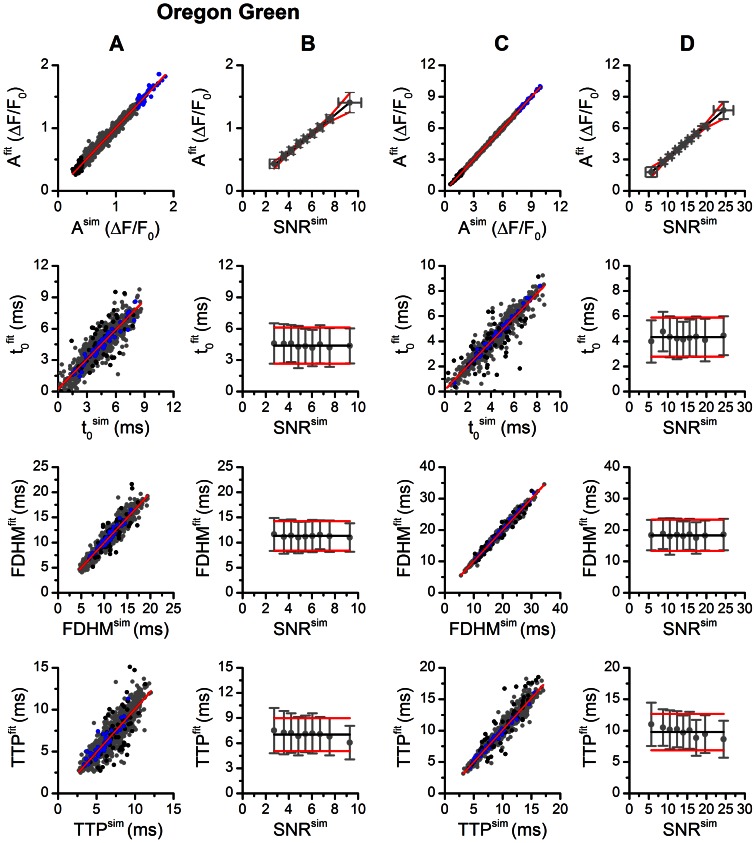
Determination of the accuracy and the precision of the estimated parameters of OG-5N (A, B) and Fluo-3 spikes (C, D).
A, C – correlation between the simulated and the fitted parameters (grey circles). Red line is the linear fit. Parameters of the spikes with the bottom 5% of SNR values (2.38±0.04 for OG-5N and 4.33±0.15 for Fluo-3) and of spikes with the top 5% of SNR values (10.11±0.12 for OG-5N and 26.68±0.29 for Fluo-3) are shown as black and blue circles, respectively. Pearson correlation coefficients between the parameters of simulated OG-5N calcium spikes and parameters of their fits were 0.986, 0.893, 0.869 and 0.942 for the A, t0, TTP and FDHM values, respectively. Pearson correlation coefficients between the parameters of simulated Fluo-3 calcium spikes and parameters of their fits were 0.999, 0.939, 0.962 and 0.993 for the A, t0, TTP and FDHM values, respectively. B, D – mean ± s.d. of the fitted parameter values grouped by the SNR values of the simulated spikes. Black lines are the mean parameter values of the simulated spikes in the absence of noise. Red lines show mean+s.d. and mean - s.d. of parameter values of noise-free simulated spikes.